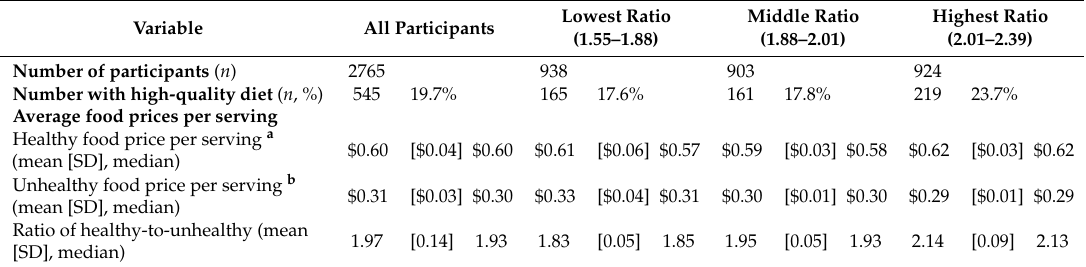
Table 2. Proportion of participants with a high-quality diet by tertile of the healthy-to-unhealthy price ratio and the average serving price of healthy and unhealthy foods ( n = 2765).